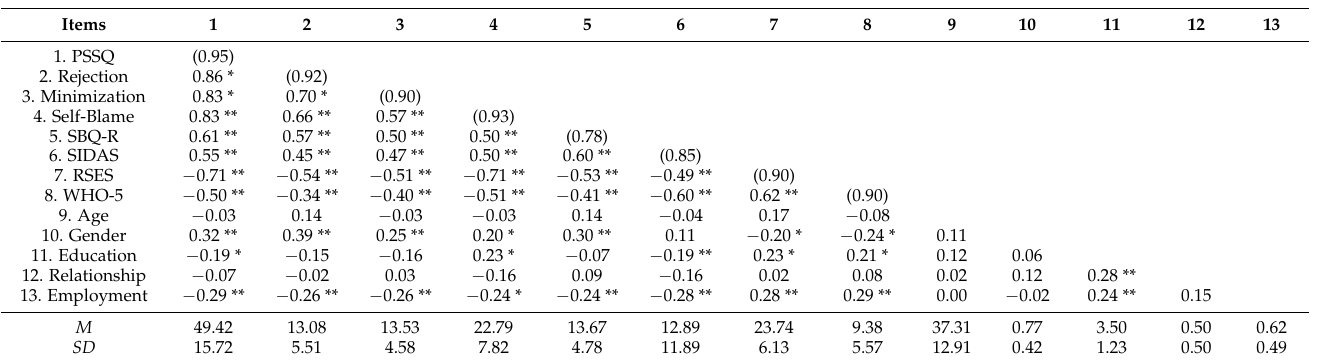
Table 1. Means, standard deviations, and intercorrelations between PSSQ Score, the measures of suicidality, self-esteem, well-being, and the demographic variables (N =